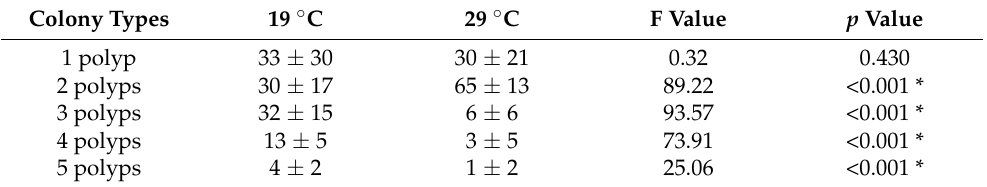
Figure 2. Pictures of Craspedacusta sowerbii polyp colony types at 19 °C (4 polyp colony), and 29 °C (2 polyp colony). Table 1. Mean ( ± standard deviation) percentage contribution of the number of Craspedacusta sowerbii polyps per colony at 19 and 29 ◦ C, respectively. *: significant difference ( p < 0.05). Colony